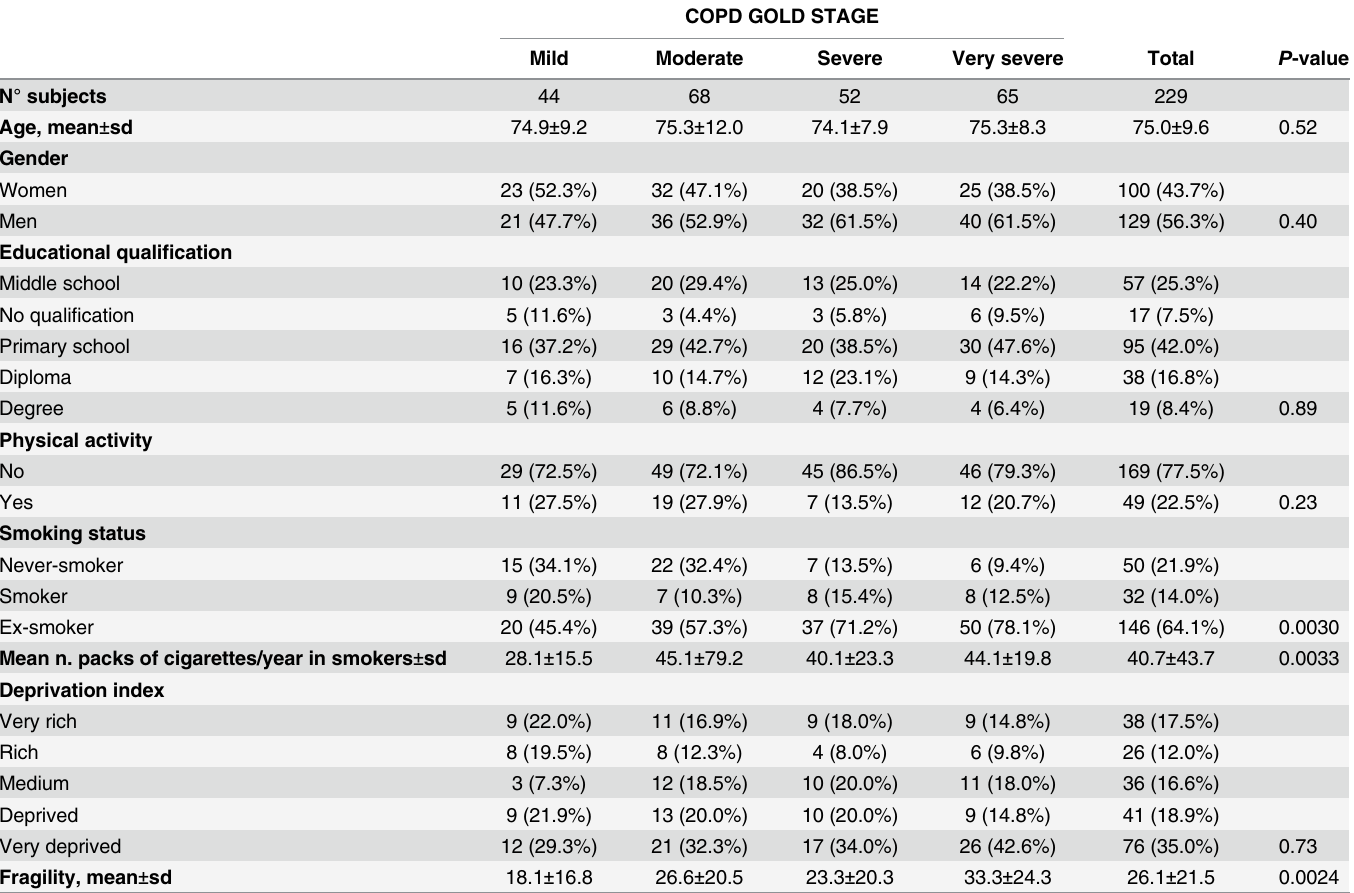
Table 1. Social and lifestyles characteristics in COPD